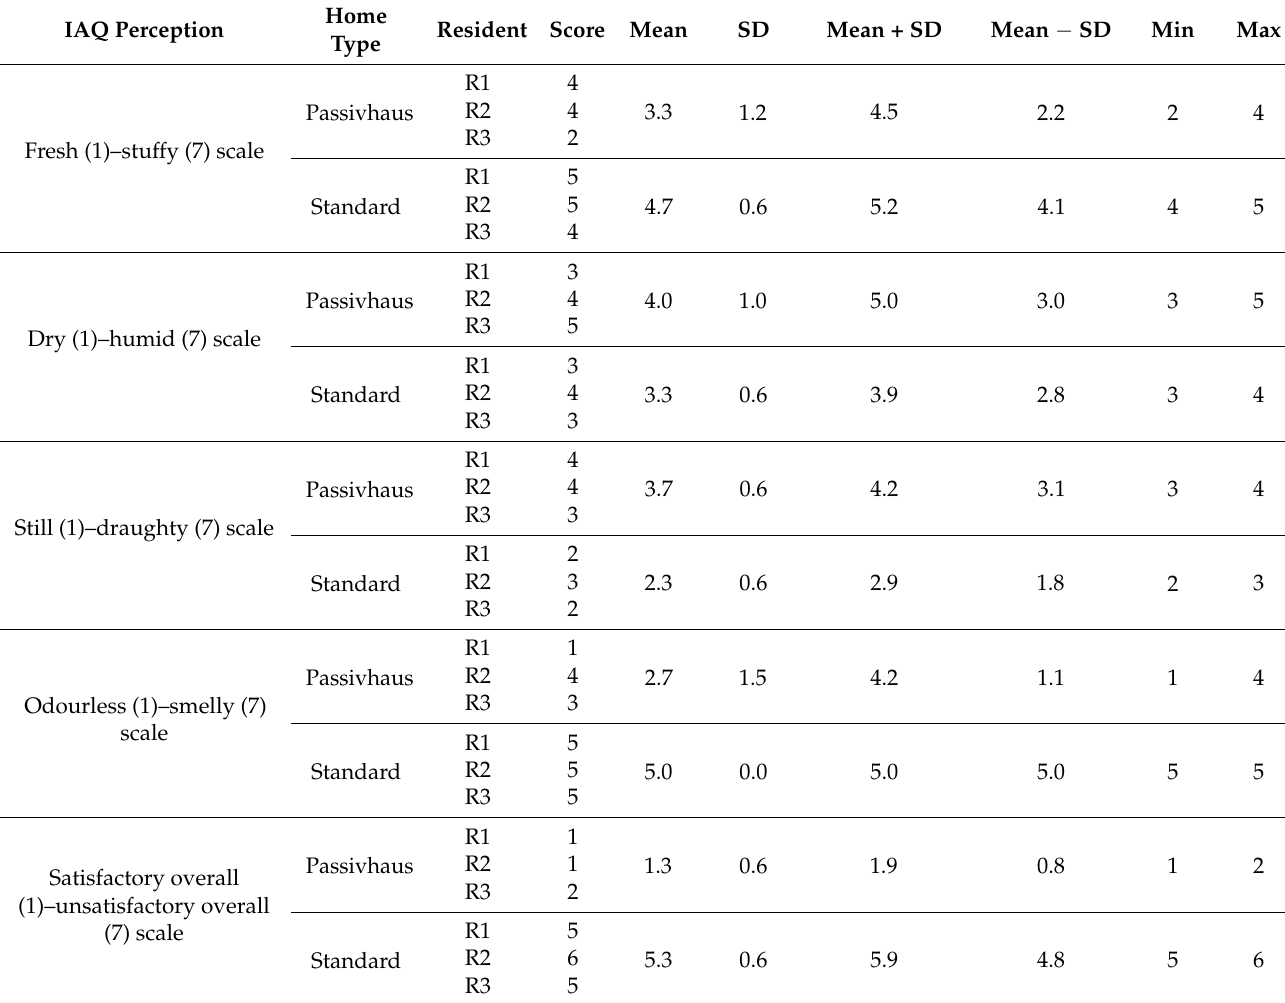
Table 6. Statistical analysis of the IAQ perceptions during winter for both homes. Source: Authors. IAQ